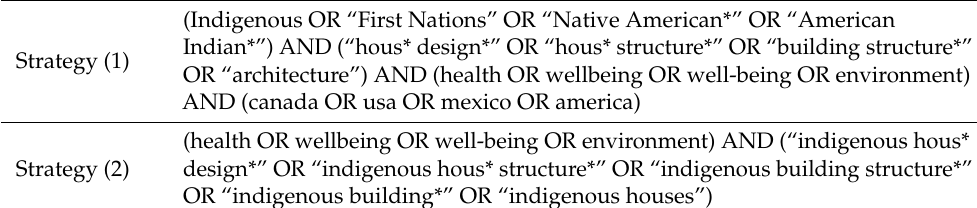
Table 2. Searching strategies June 2022.